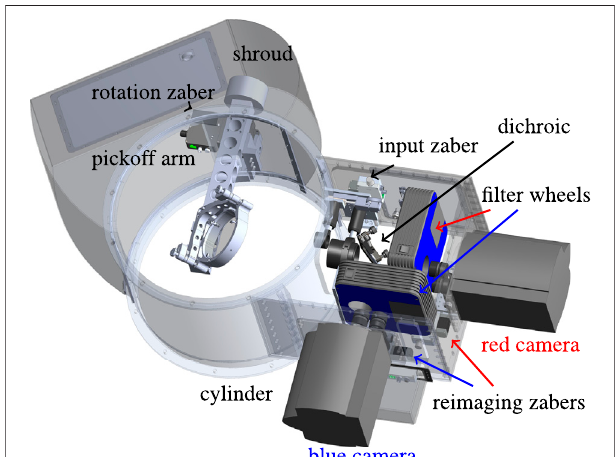
FIGURE 2 | The Gemini Speckle Instruments –‘ Alopeke and Zorro. The two instruments are identical and are constructed to make use of limited space between the instrument mounting surface and a calibration unit at the Gemini telescopes. As much as possible, commercial off the shelf (COTS) parts were used in the “ optics bench in a box ” housing. The main structuralcomponentisarolledaluminumcylinder thatreplacedasheetmetal light baf fl e. For reference, the inner diameter of this cylinder is 0.4 m with a height of 0.28 m. The box housing the optics and components is 0.32 m on a side. The main parts of the instruments are labelled: the structural cylinder, pick-off arm and mirror with Newport Pico motors for alignment, collimating and re-imaging lenses mounted on motorized stages made by Zaber Inc., Newport fi lter wheels and Andor EMCCD cameras.